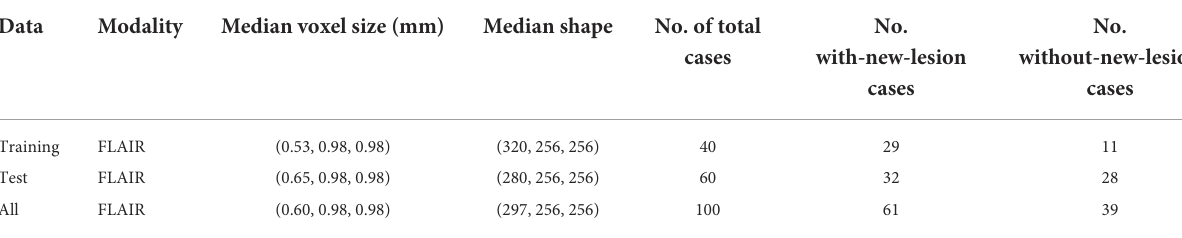
TABLE 1 An overview of the MSSEG-2